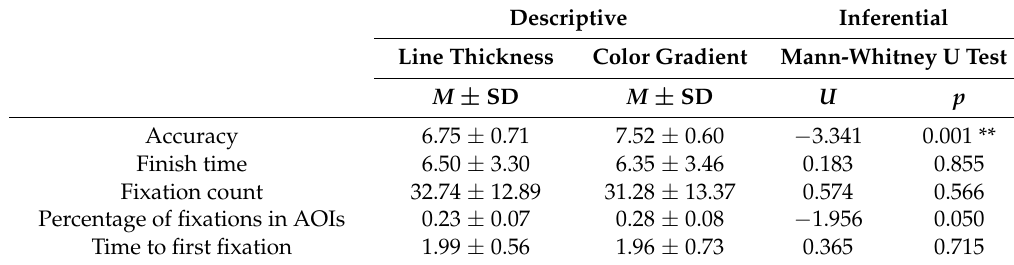
Table 4. Descriptive and inferential statistics for line thicknesses and color gradients.